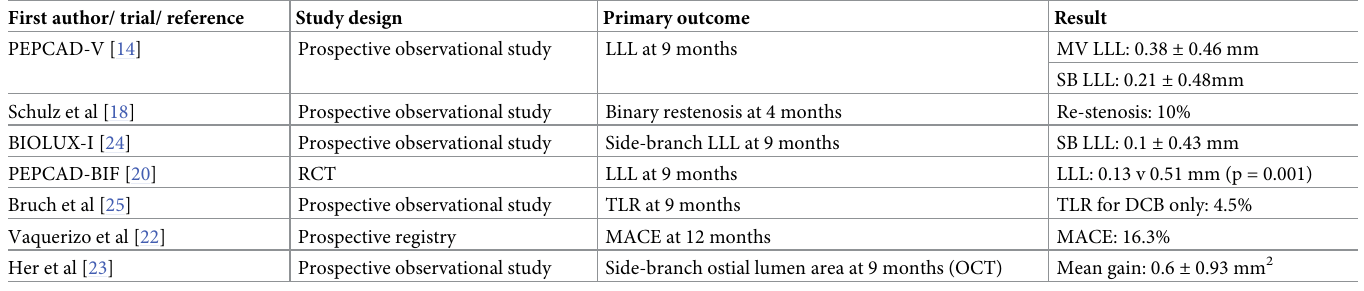
Table 3. Summaries of results from all studies not included in the focused